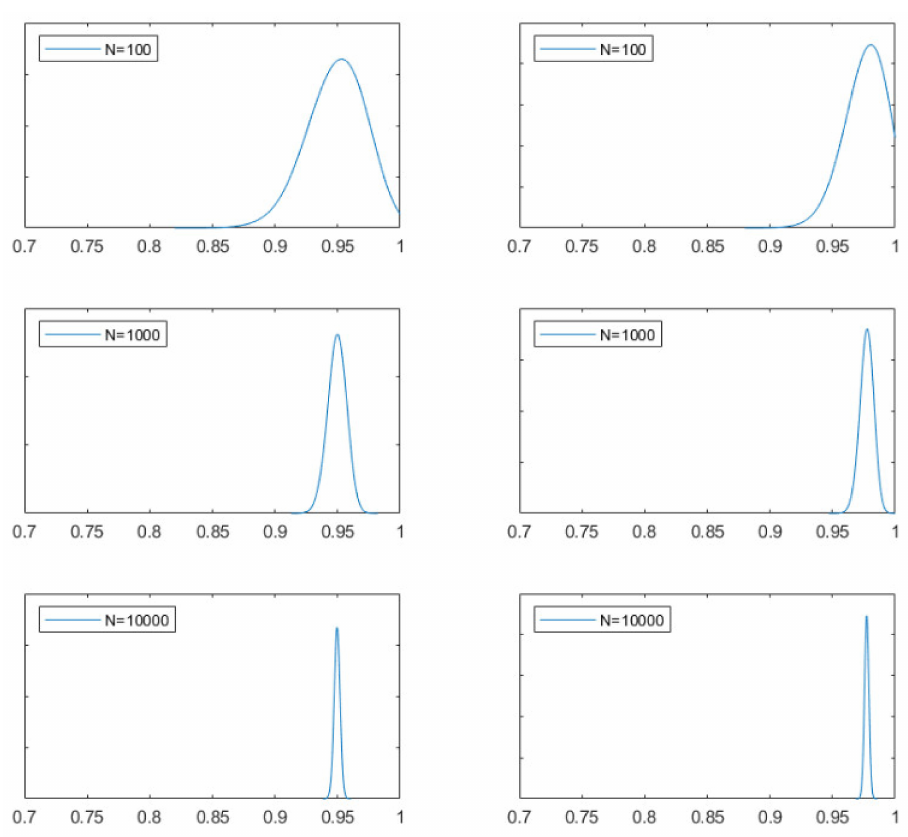
Figure A2. Tolerance Interval α -Coverage with Finite